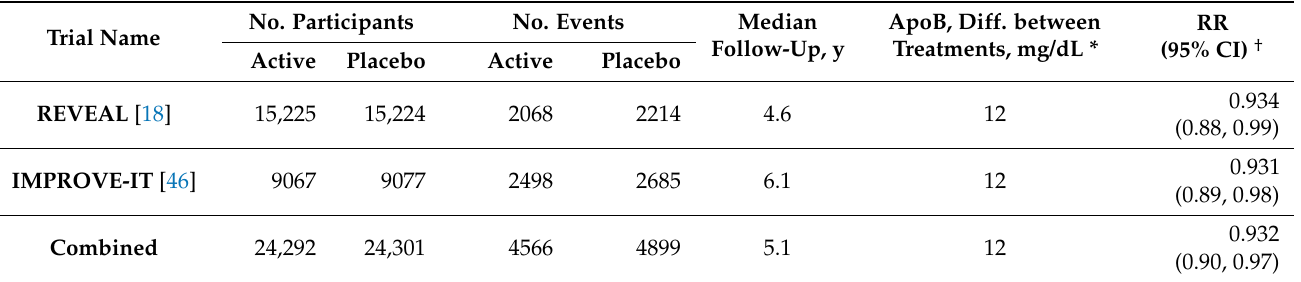
Table 2. Reduction in risk of major cardiovascular events per unit change in apolipoprotein B in cardiovascular outcome trials of anacetrapib and